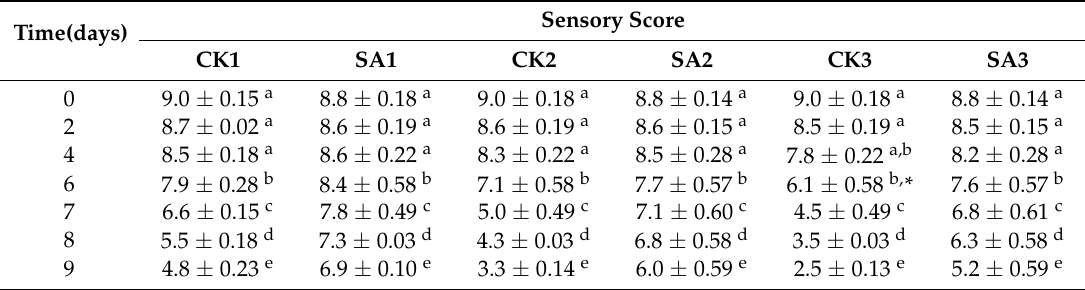
Figure 3. Effect of CFS from A. sobria on sensory quality of Pacific white shrimp ( L. vannamei ) during different cold chain logistics. Table 2. Effect of CFS from A. sobria on sensory quality of Pacific white shrimp ( L. vannamei ) during different cold chain logistics by F test.